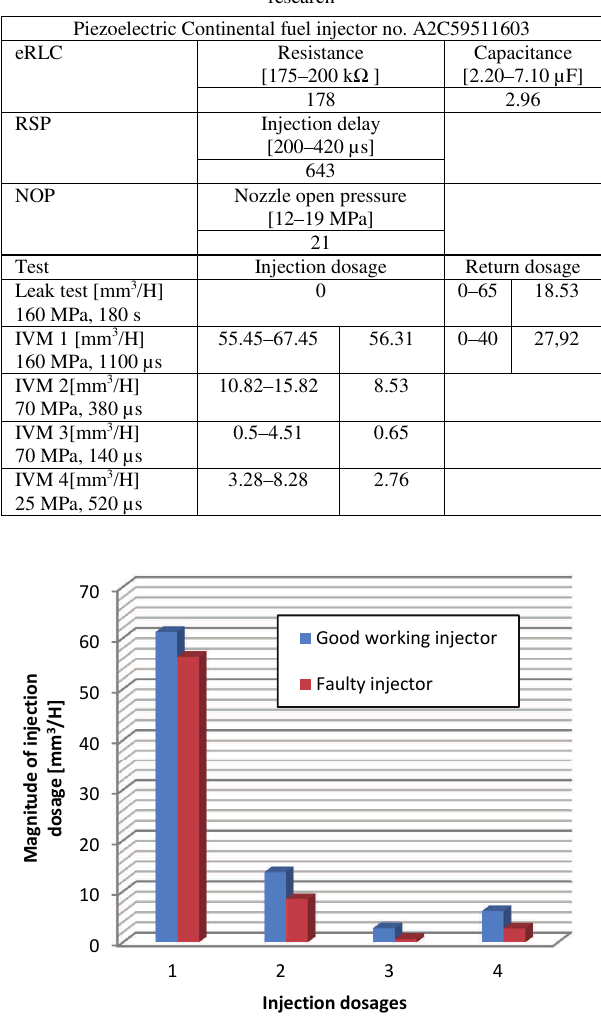
Fig. 16. Injection dosages comparison between faultless and faulty piezoe- lectric Continental fuel injector 1 – full load dosage, 2 –medium load dosage, 3 – initial dosage, 4 – idle speed dosage